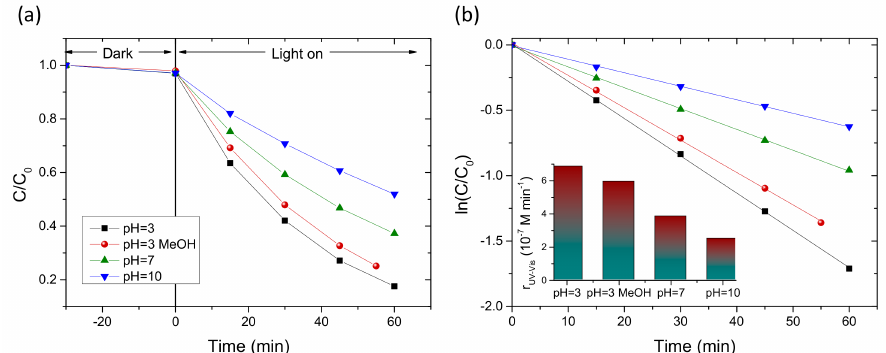
Figure 9. SA photodegradation kinetics by GQD-PC211 films under UV–VIS light for pH values of 3, 7, and 10 and in the presence of 0.01 M MeOH at pH = 3. ( a ) ln( C / C 0 ) vs. t ; ( b ) ln( C / C 0 ) vs. t plots. The inset in ( b ) shows the corresponding reaction rates.